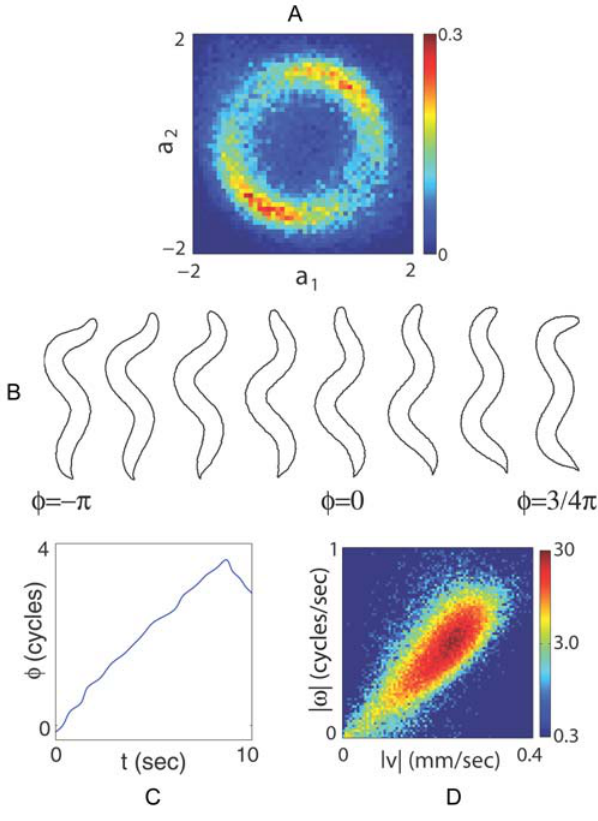
Figure 3. Motions along the first two eigenworms. (A) The joint probability density of the first two amplitudes, r ( a 1 , a 2 ), with units such T ~ S a 2 T ~ 1 . The ring structure suggests that these modes form that S a 2 1 2 an oscillator with approximately fixed amplitude and varying phase w =tan -1 (- a 2 / a 1 ). (B) Images of worms with different values of w show that variation in phase corresponds to propagating a wave of bending along the worm’s body. (C) Dynamics of the phase w ( t ) shows long periods of linear growth, corresponding to a steady rotation in the { a 1 , a 2 } plane, with occasional, abrupt reversals. (D) The joint density r (| n |,| v |). The phase velocity v = d w / dt in shape space predicts worm’s crawling speed.